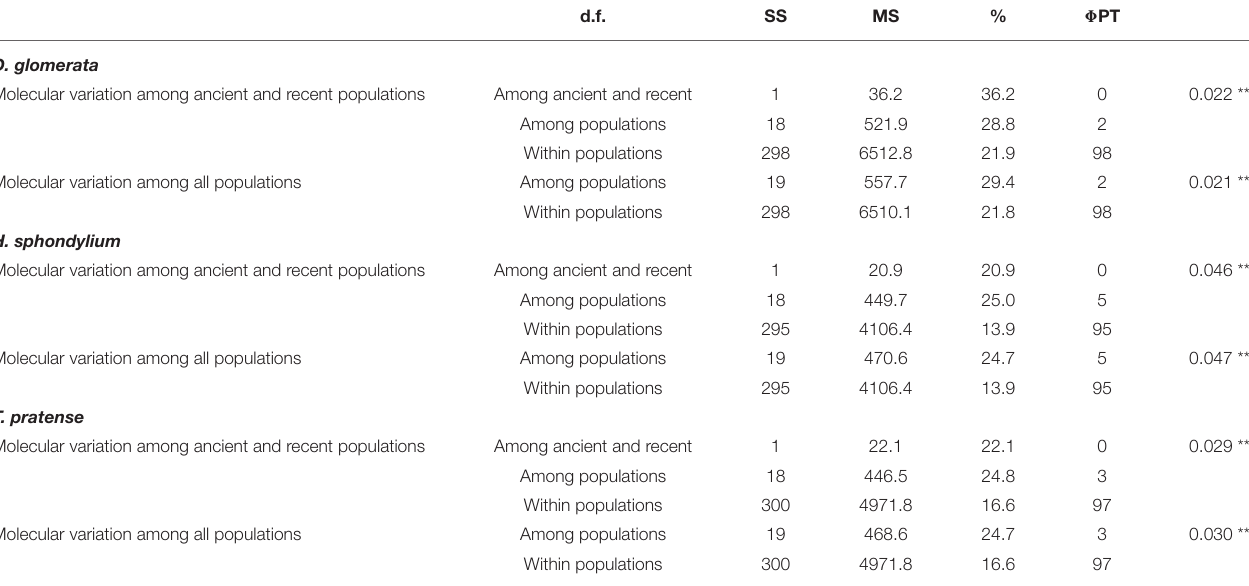
TABLE 3 | Results of the Three-Level AMOVA given as the genetic variation among ancient and recent populations, as well as among all and within the respective populations of the studied species.